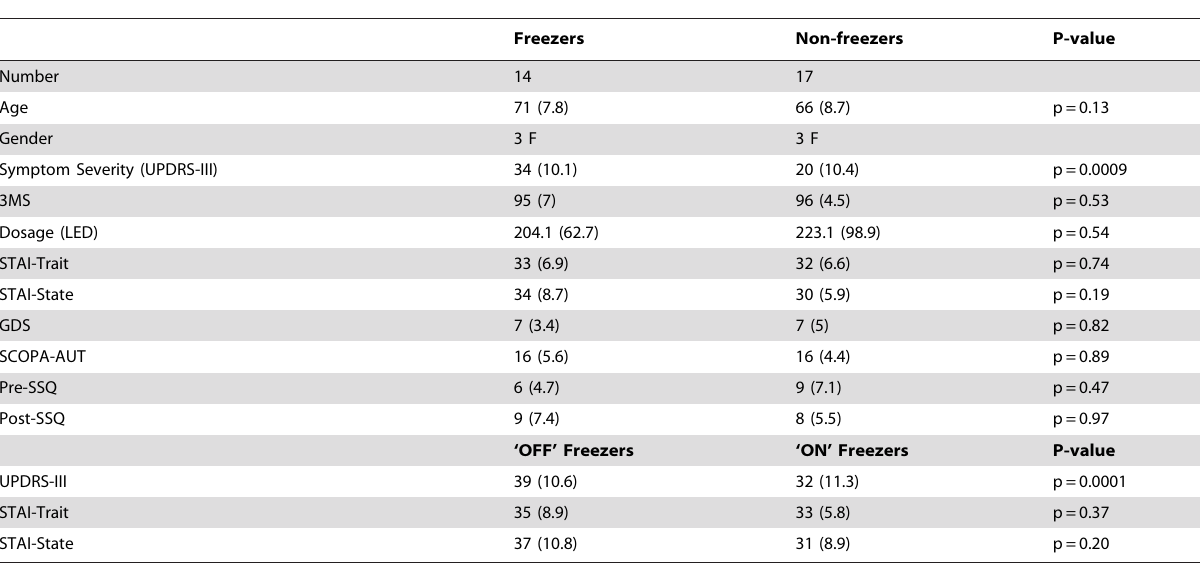
Table 1. Demographic characteristics and clinical details of participants.